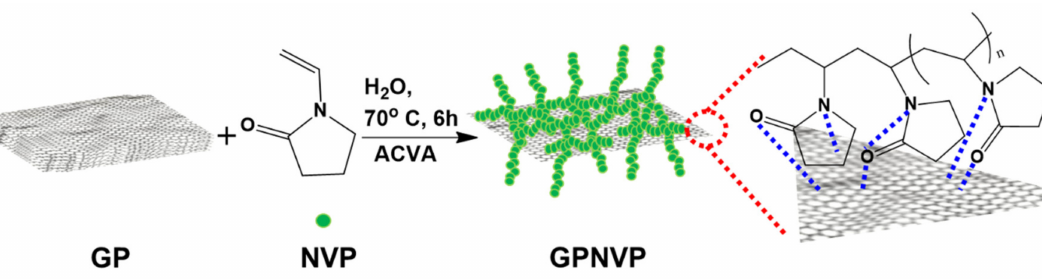
Scheme 1. Preparation of graphene surface functionalized by poly- N -vinyl-2-pyrrolidone using in situ